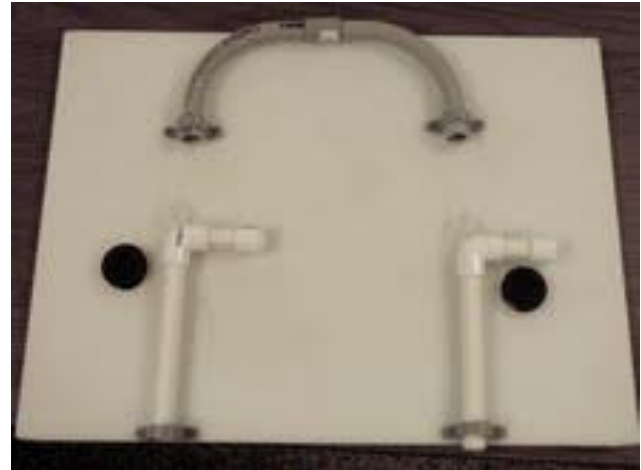
Figure 1 . The apparatus layout.